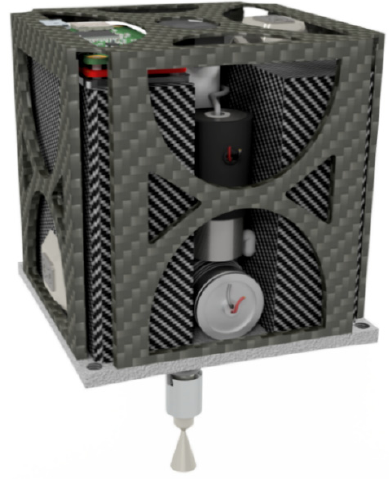
Figure 1. MIMPS-G500mN realistic